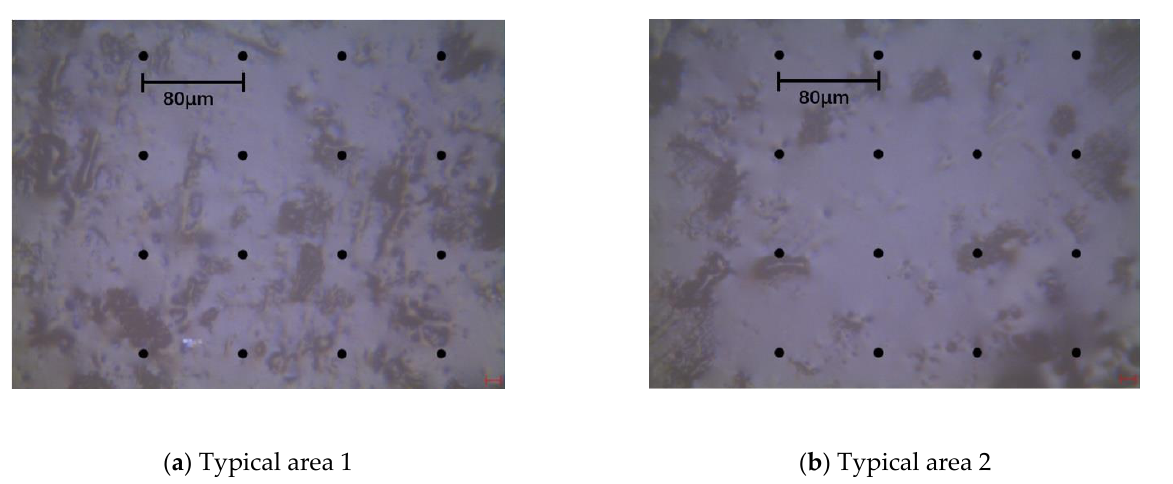
Figure 5. Microscopic images of the nanoindentation test area of asphalt mastic samples.